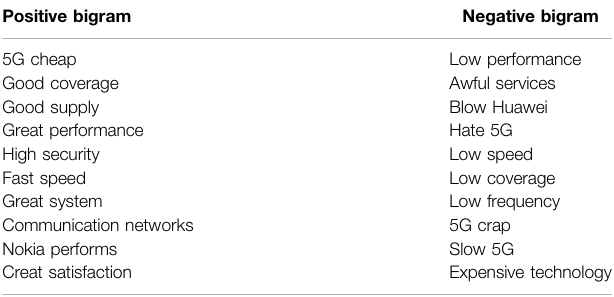
TABLE 5 | Most frequent positive bigrams for next generation mobile network (5G).